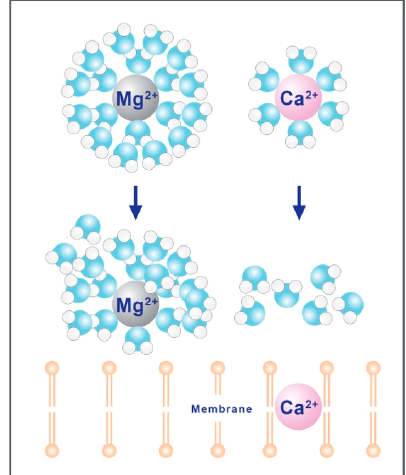
Figure 5. Hydration shells of both magnesium and calcium. The hydrated radius of magnesium is >400 times larger than its dehydrated radius, which is much more prominent than calcium (~25-fold difference) [83,84]. This increase in radius, unlike calcium, prevents magnesium from passing through narrow ion channels.